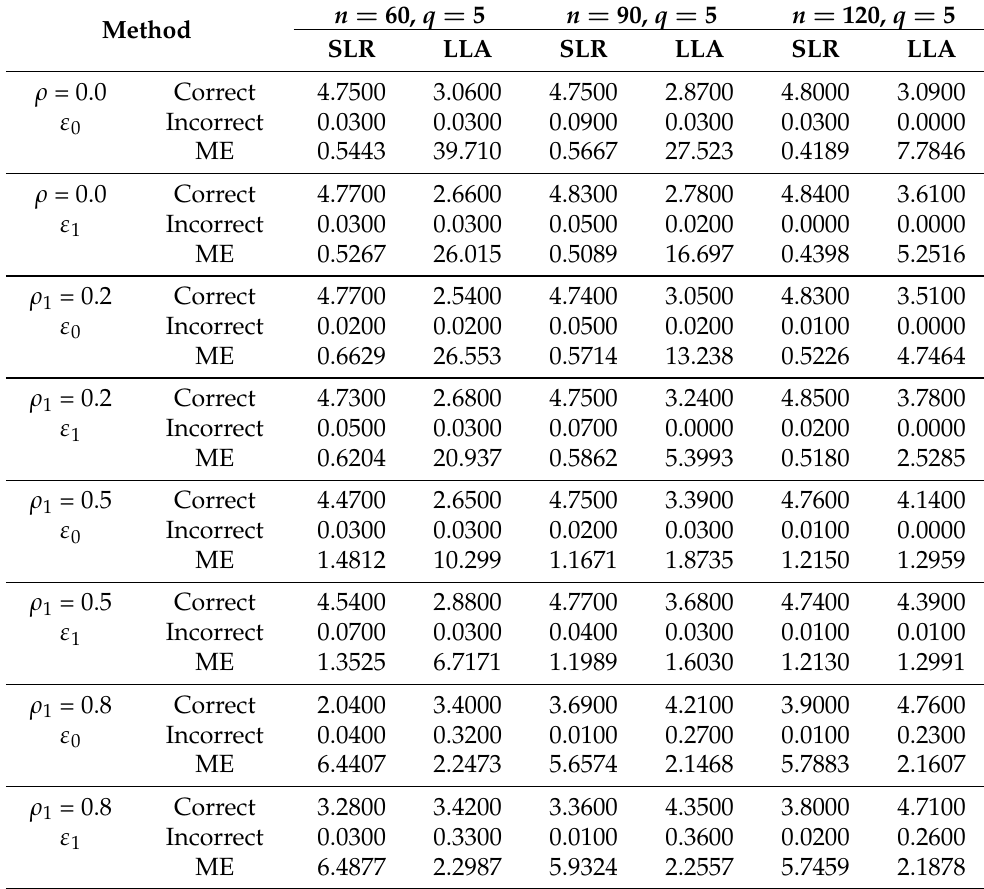
Table 1. Simulation results of variable selection via SCAD penalty function ( q =